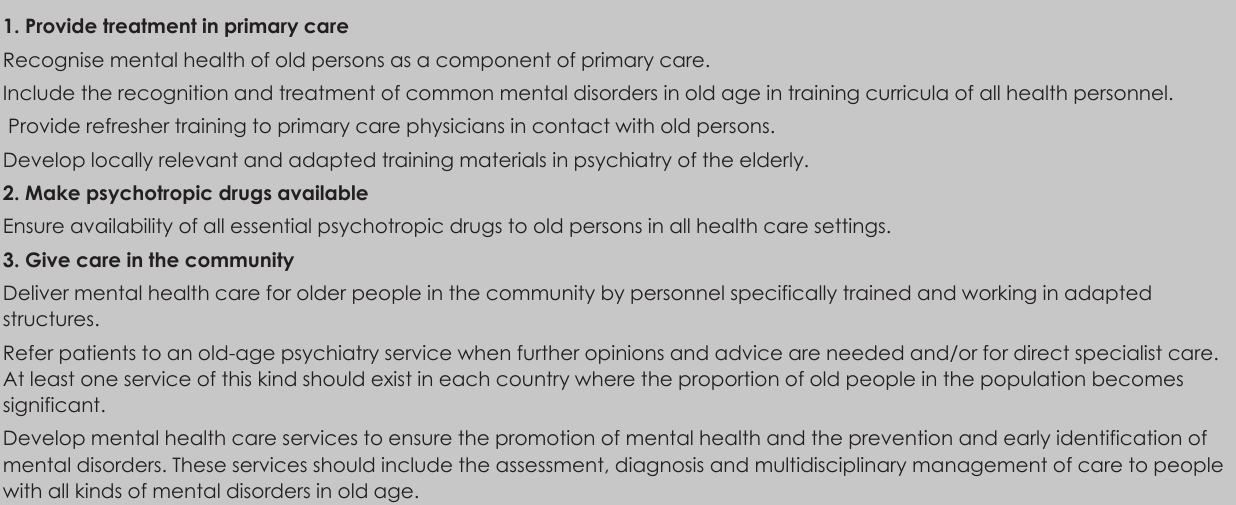
Table II. Minimum actions required for mental health care for old